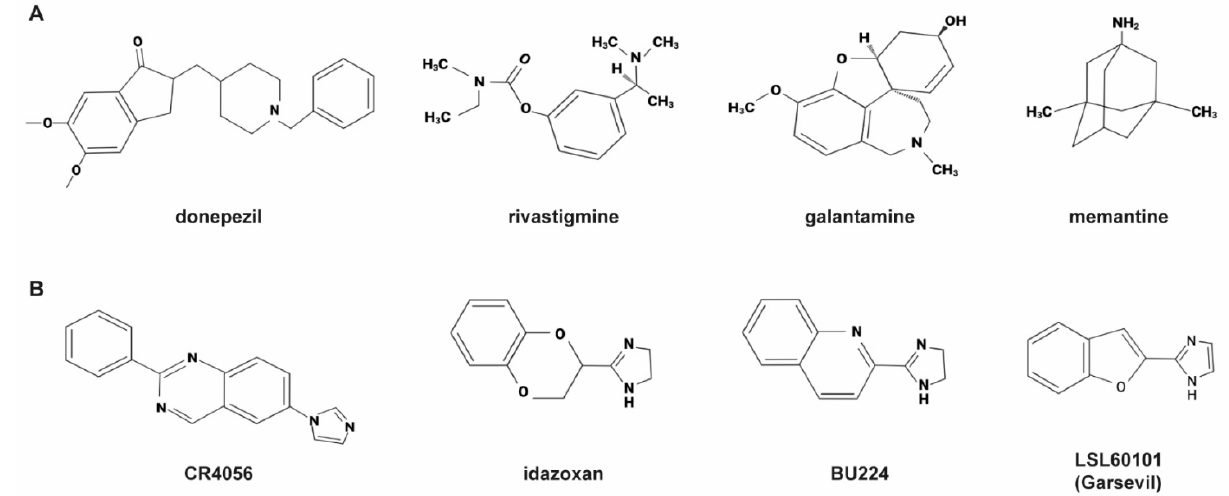
Figure 1. Chemical structure of drugs currently used to treat AD patients ( A ) and I2-imidazoline ligands ( B ). Created with BioRender.com.